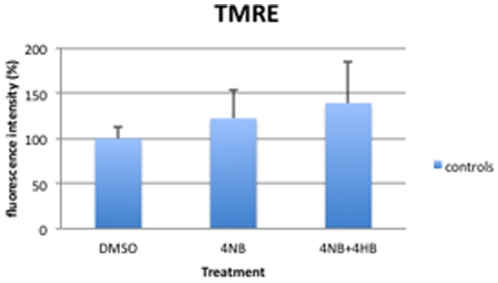
Assessment of mitochondrial membrane potential by TMRE in control skin fibroblasts (n = 5) after co-treatment with 4 mM 4-NB+2 mM 4-HB.The values are expressed as percentage of the control skin fibroblasts after 4 mM DMSO.